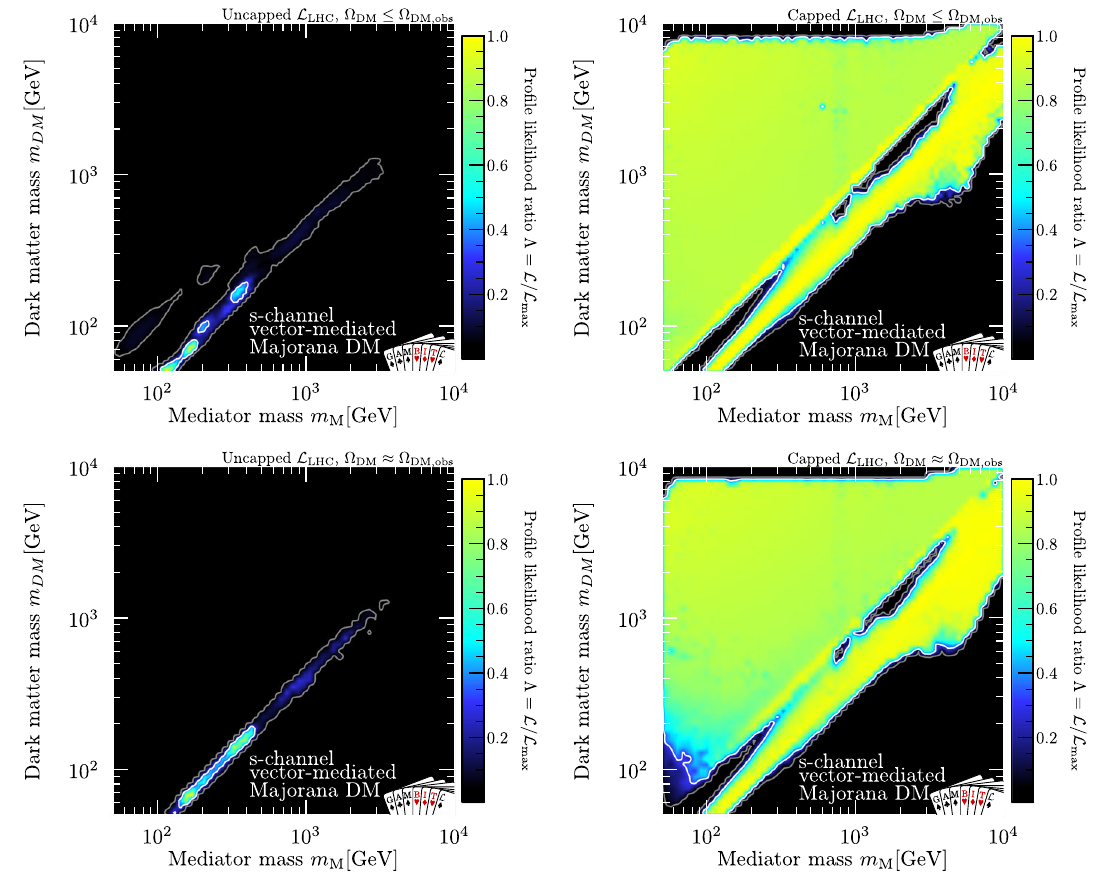
Fig. 8 Profile likelihood for the Majorana fermion DM model. The observed relic density of DM is taken as an upper limit (top) or a two- sided measurement that the model must match (bottom). The collider